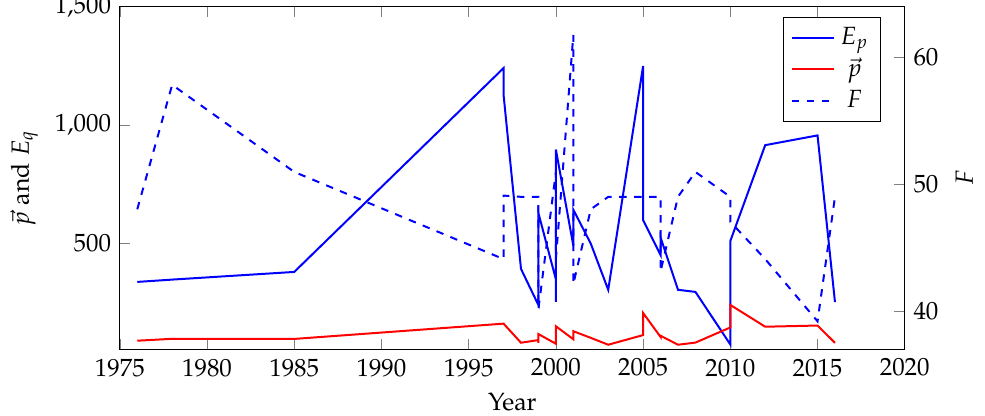
Figure 1. Motions changes of the roller coaster ride during different